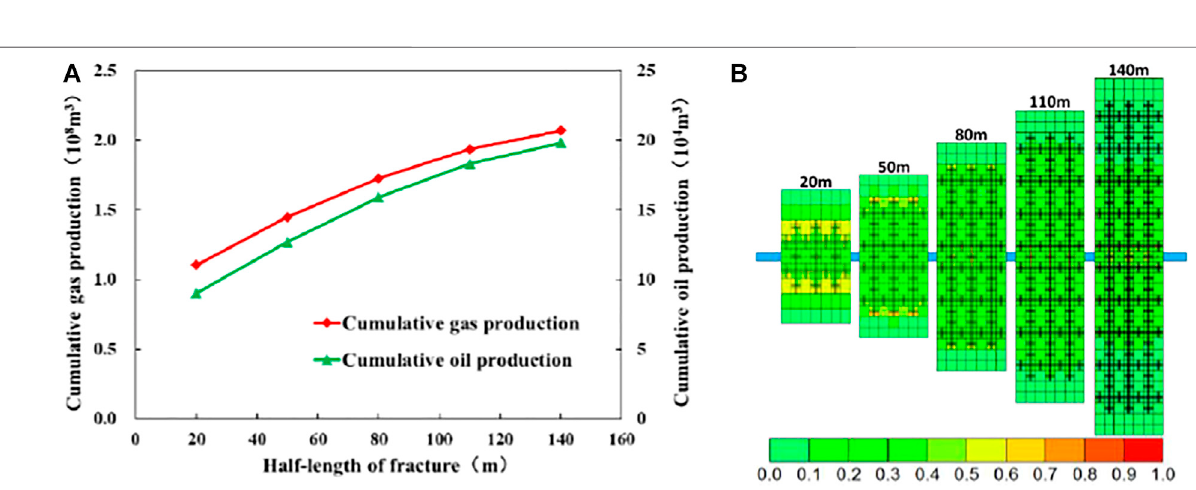
Frontiers in Earth Science |